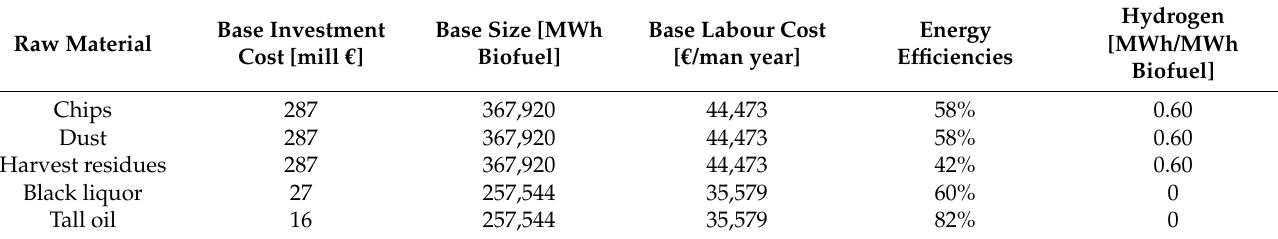
Table 3. Main input parameters for biofuel production used in the analyses. Source: [20,67,68].